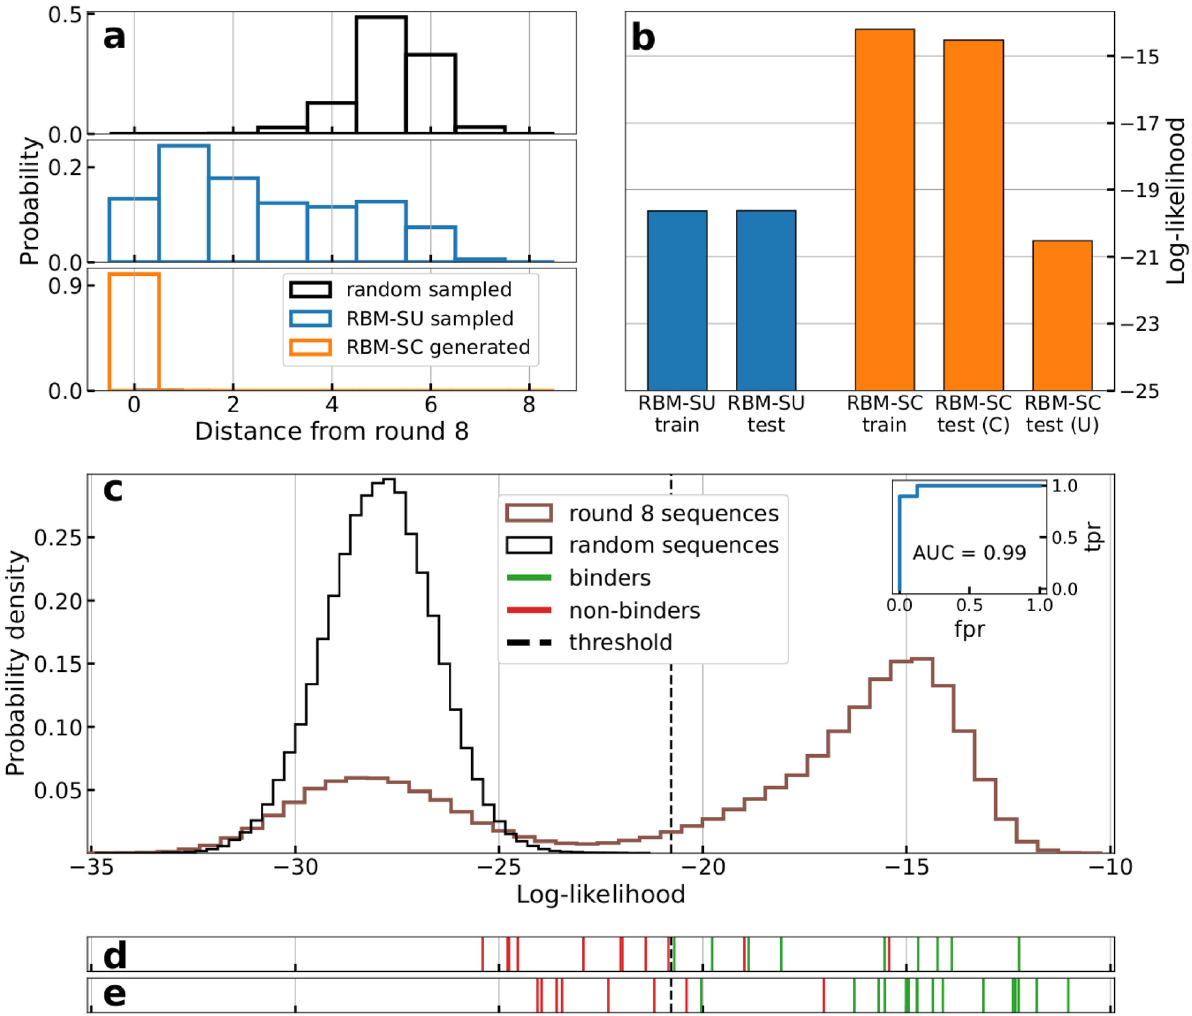
Fig 5. RBM can be used to design new aptamers binding thrombin. a : Histograms of distances to dataset of the best (top 5% in terms of log- likelihoods) sequences generated by RBM-SC (orange) and RBM-SU (blue) trained on round 8 data. The black histograms show the distribution obtained with sequences generated uniformly at random. b : Average log-likelihoods of training (90% of the unique sequences observed at round 8, chosen at random) and test (remaining 10% of unique sequences) sets for RBM-SU and RBM-SC (after re-introduction of counts). For RBM-SC, the average log-likelihood of the test set is shown either when weighing each sequence with (C) or without (U) its counts. For the RBM-SU model we show the unweighted average-log likelihood on the training and testing sets respectively. c : Histogram of the log-likelihoods of all unique aptamers observed in the last round (blue line) and of uniformly random sequences (orange line), computed with RBM-SU trained on the same data (blue line). Inset: AUC computed on the sequences generated by the RBM-SC model (panel E). d : Vertical lines locate the log-likelihoods of sequences experimentally validated to be binders (green) or non binders (red). Sequences taken from a preliminary set described in S1 Table. Results allow us to determine the binding/non binding threshold, located with the black dashed line. e : Same as panel D, for sequences designed with the RBM-SU model trained on round-8 sequences, as described in Sec RBM trained from unique sequences generate diverse aptamers capable of binding thrombin, see Table